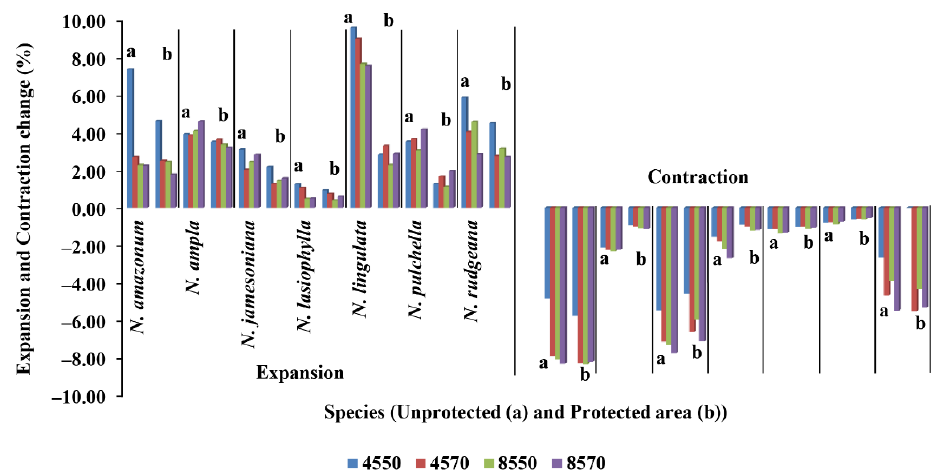
Figure 4. Land use characteristics in South America within the water lily ( Nymphaea )-accessible area (M), indicating the land use category in protected and unprotected areas.